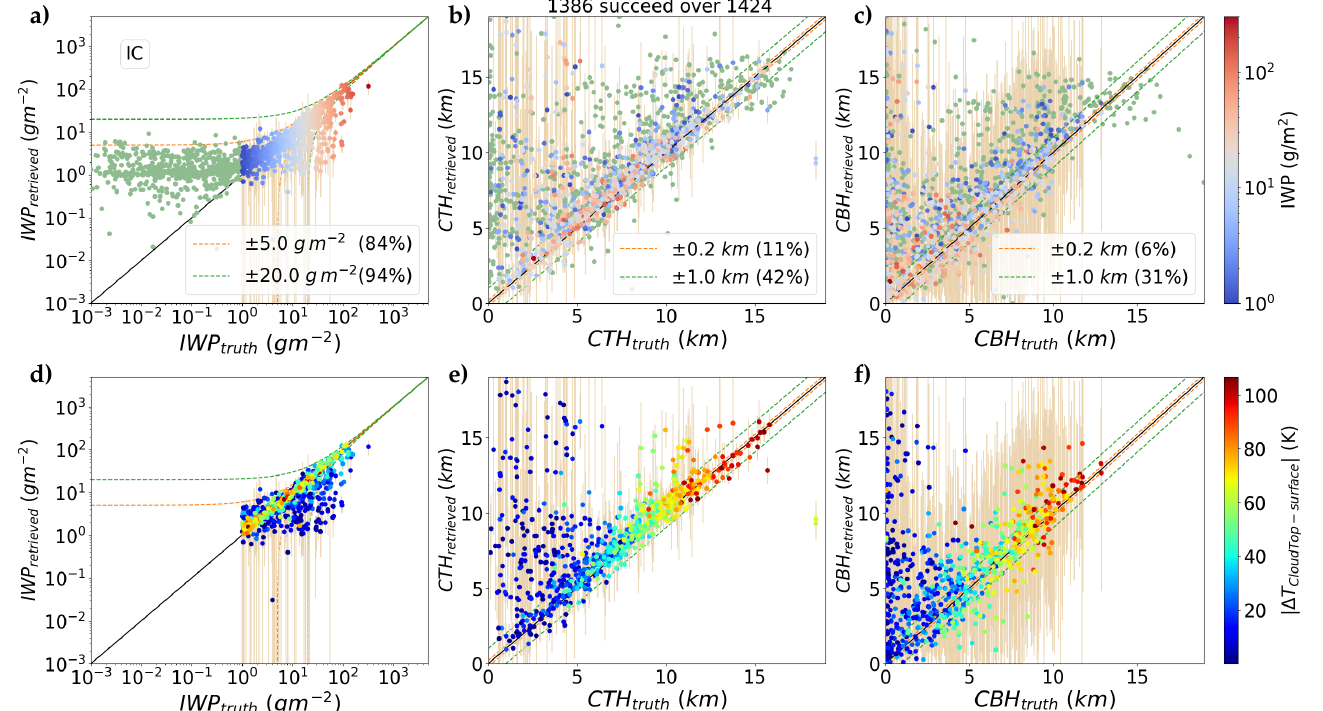
Figure 7. Retrievals of IWP ( left , a , d ), CTH ( center , b , e ), and CBH ( right , c , f ) for IC cloud configuration from IASI synthetic radiances as a function of the true state over all the profile database. In the top pannel ( a – c ), the clouds whose IWP is lower than 1 g/m 2 are depicted in green. The color code corresponds to the IWP of the clouds. In the bottom panel ( d – f ), the clouds whose IWP is lower than 1 g/m 2 have been removed. The color code is related to the temperature contrast between the cloud layer and surface. The error bars are plotted in beige. The dotted lines indicate the goal (orange) and threshold (green) given by the Word Meteorological Organization in order to reduce uncertainties in weather forecasts. The associated percentage corresponds to the proportion of cases that satisfy the OSCAR goal and